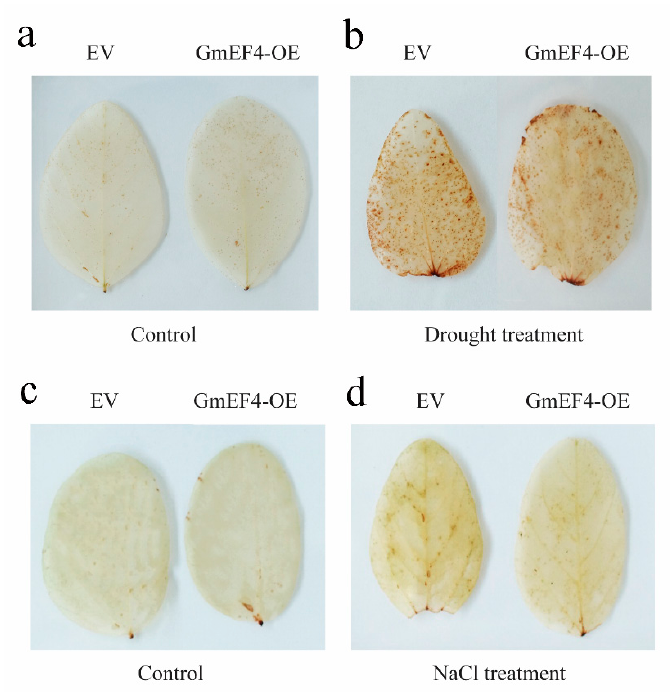
Figure 8. DAB staining of GmEF4 -overexpressing ( GmEF4 -OE) and EV-control plants under drought and salt treatments. ( a ) and ( b ) DAB staining of GmEF4 -OE and EV-control transgenic soybean plants under normal and drought treatment. ( c ) and ( d ) DAB staining of GmEF4 -OE and EV-control transgenic soybean plants under normal and salt treatment.